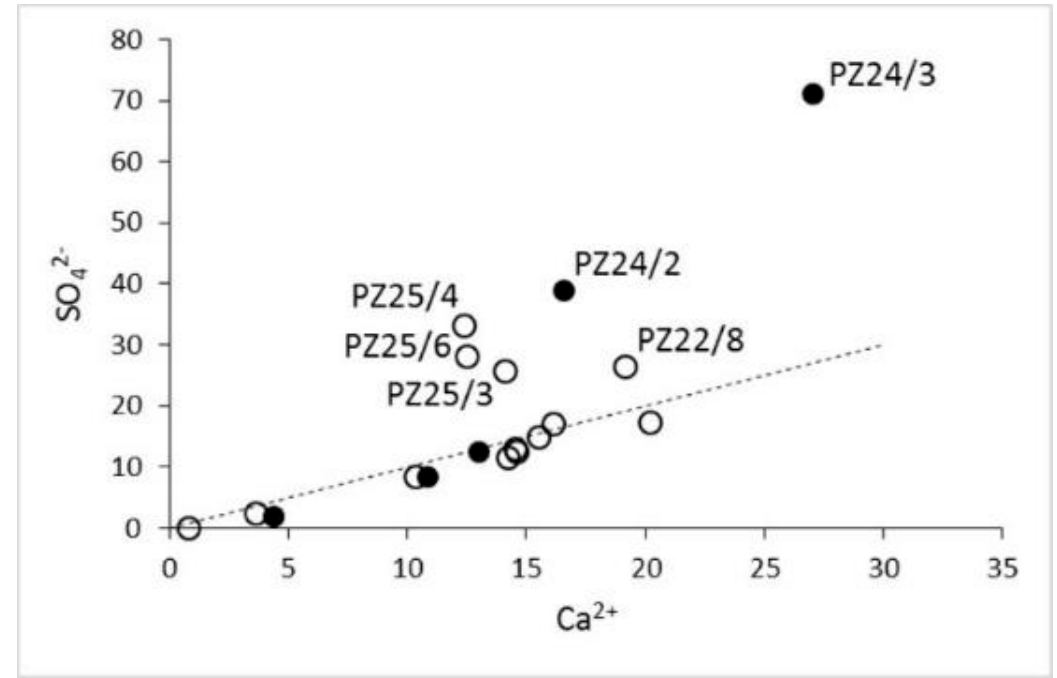
Figure 10. Ca 2 + (mol / L) vs. SO 42 − (mol / L) correlation diagram. The SO 42 − / Ca 2 + = 1 stoichiometry is shown (dashed line). Waters that deviates towards a relative sulphate enrichment are labelled. Symbols as in Figure 9.